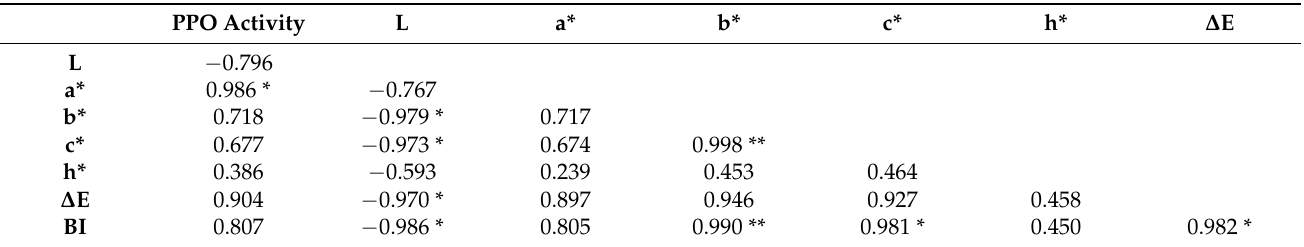
Table 4 shows Pearson’s correlation coefficient among the colorimetric parameters and PPO activity in eggplant slices exposed to air over time. According to the results, there is a redder eggplant slices are, the more PPO activity they have. Moreover, the PPO activity has high positive correlations with BI and ∆ E, which shows the importance of the PPO enzyme in the color change of the samples. Table 4. Pearson’s correlation among different parameters in eggplant